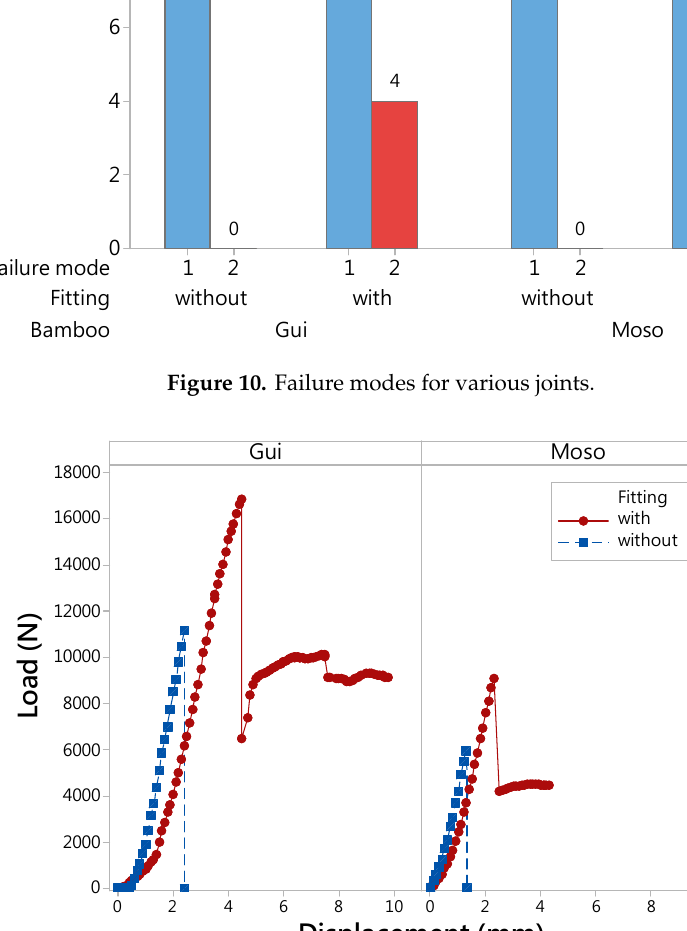
Figure 11. Load–displacement curves of steel-sleeved Gui and Moso bamboo joints, with and without wood fittings.